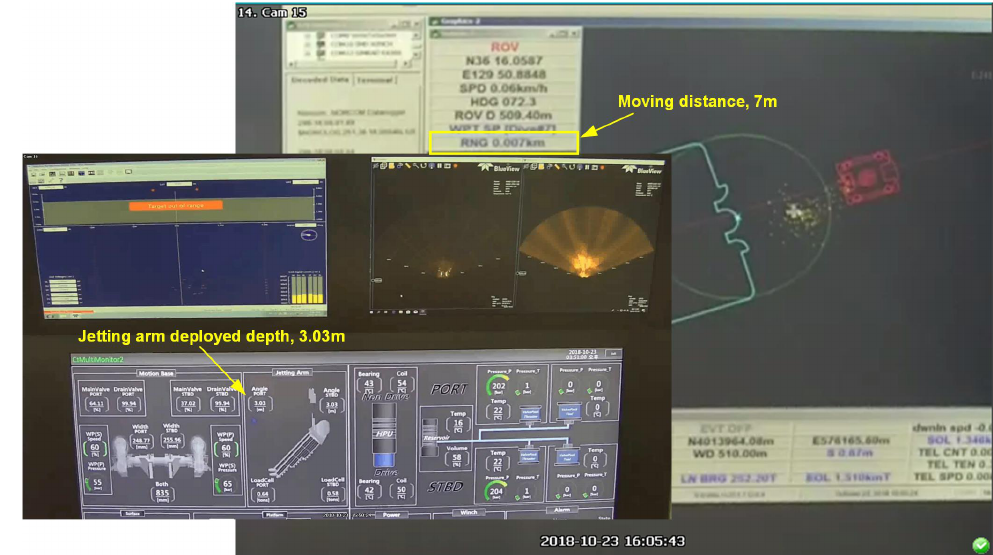
Figure 14. Verification of 3 m maximum trench